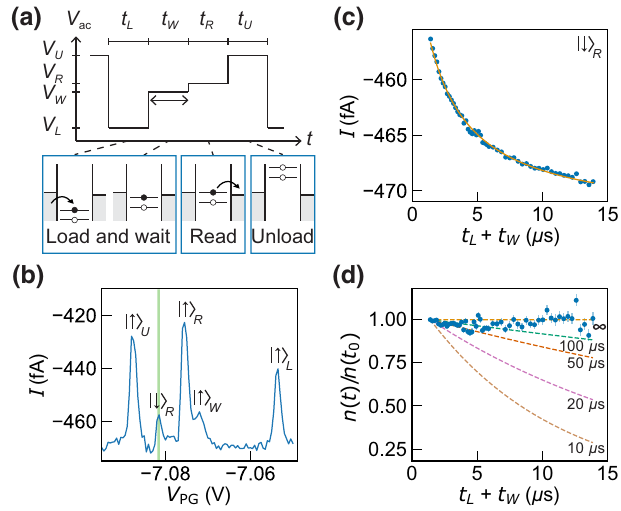
FIG. 2. (a) Four-level pulse scheme for relaxation-time mea- surements. The hole enters a random state during the load phase. If the hole is loaded into the GS it will stay there and no transport current can flow. If the carrier is loaded into the ES and does not relax during t L + t W , the charge carrier can tunnel out, resulting in a transport current in the read phase. The QD is then emptied in the unload phase and the cycle is repeated. (b) Current as a func- tion of plunger gate voltage while applying the four-level pulse. We observe various peaks corresponding to GS and ES levels of different pulse phases being aligned with the bias window. This measurement is taken in a second cooldown at a B ⊥ = 1.9 T, leading to a slight shift of V PG . (c) Current corresponding to ES transport during the read phase [shaded in green in (b)] as a func- tion of loading and waiting time. We vary the waiting time while the loading time remains constant at t L = 1 μ s. The decay results from a combination of lower cycling rate and ES relaxation time. As described in the main text the decay is dominated by sig- nal decay. (d) Normalized average number of charge carriers per pulse cycle. Dashed color lines represent the decays with the cor- responding relaxation time. Our result indicates that relaxation does not play a significant role during the measurement window.